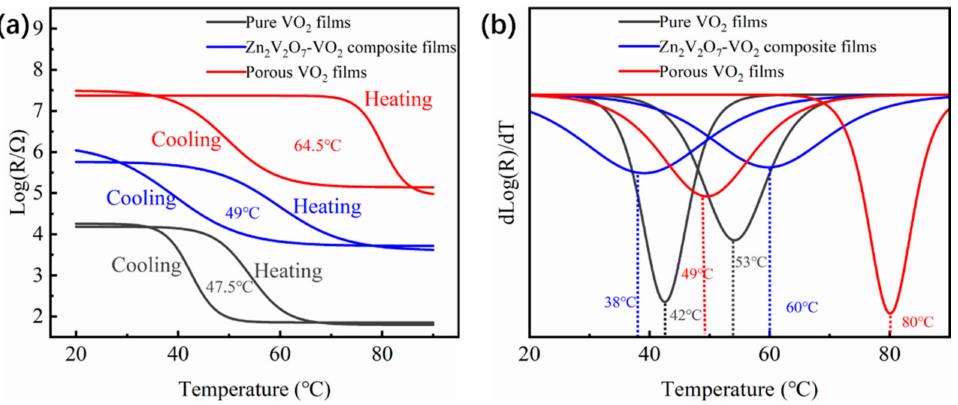
Figure 6. ( a ) the electrical hysteresis loop and ( b ) the corresponding differential for temperature of pure VO 2 film, Zn 2 V 2 O 7 -VO 2 composite films and porous